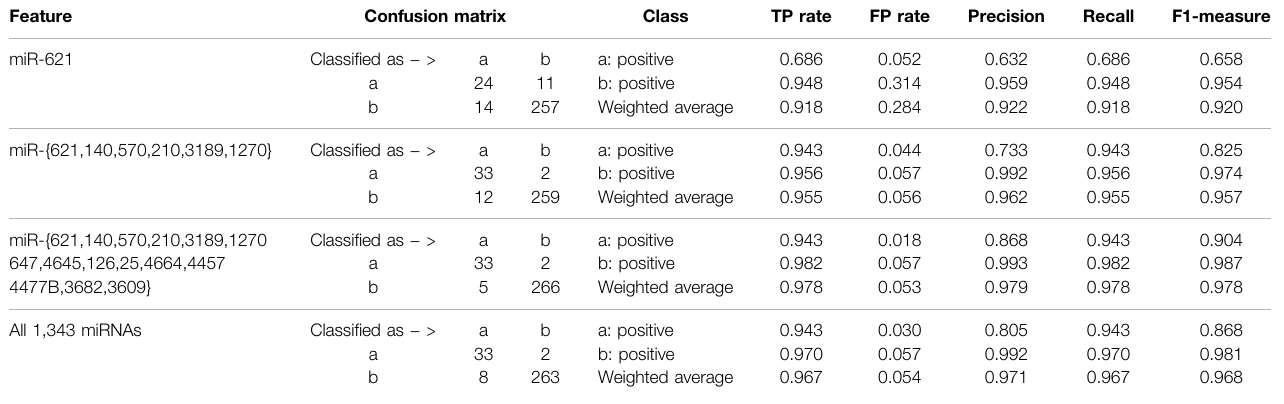
TABLE 1 | Quantitative results after variable selection corresponding to one-time sample